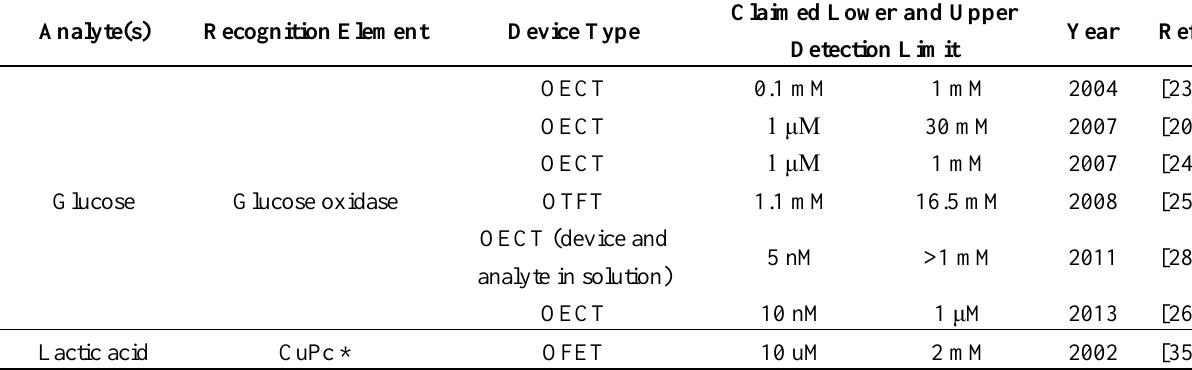
Table 1. A summary of the biosensor devices discussed in this review. The bounds on detectable analyte concentrations are given in molar ratios where possible. * Denotes the use of a non-specific electrochemical mechanism. CuPc, copper phthalocyanine;